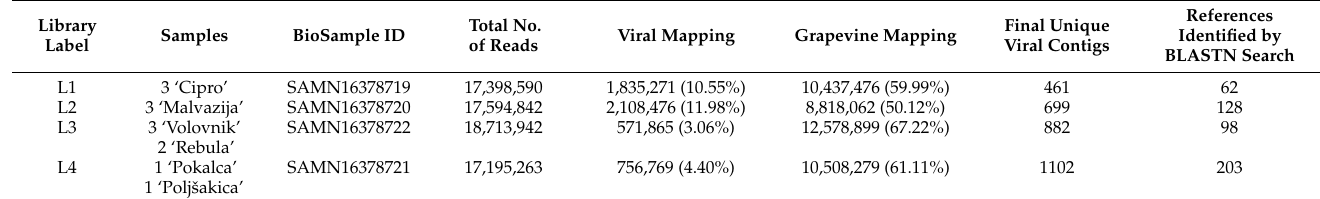
Table 2. Summary of results obtained with